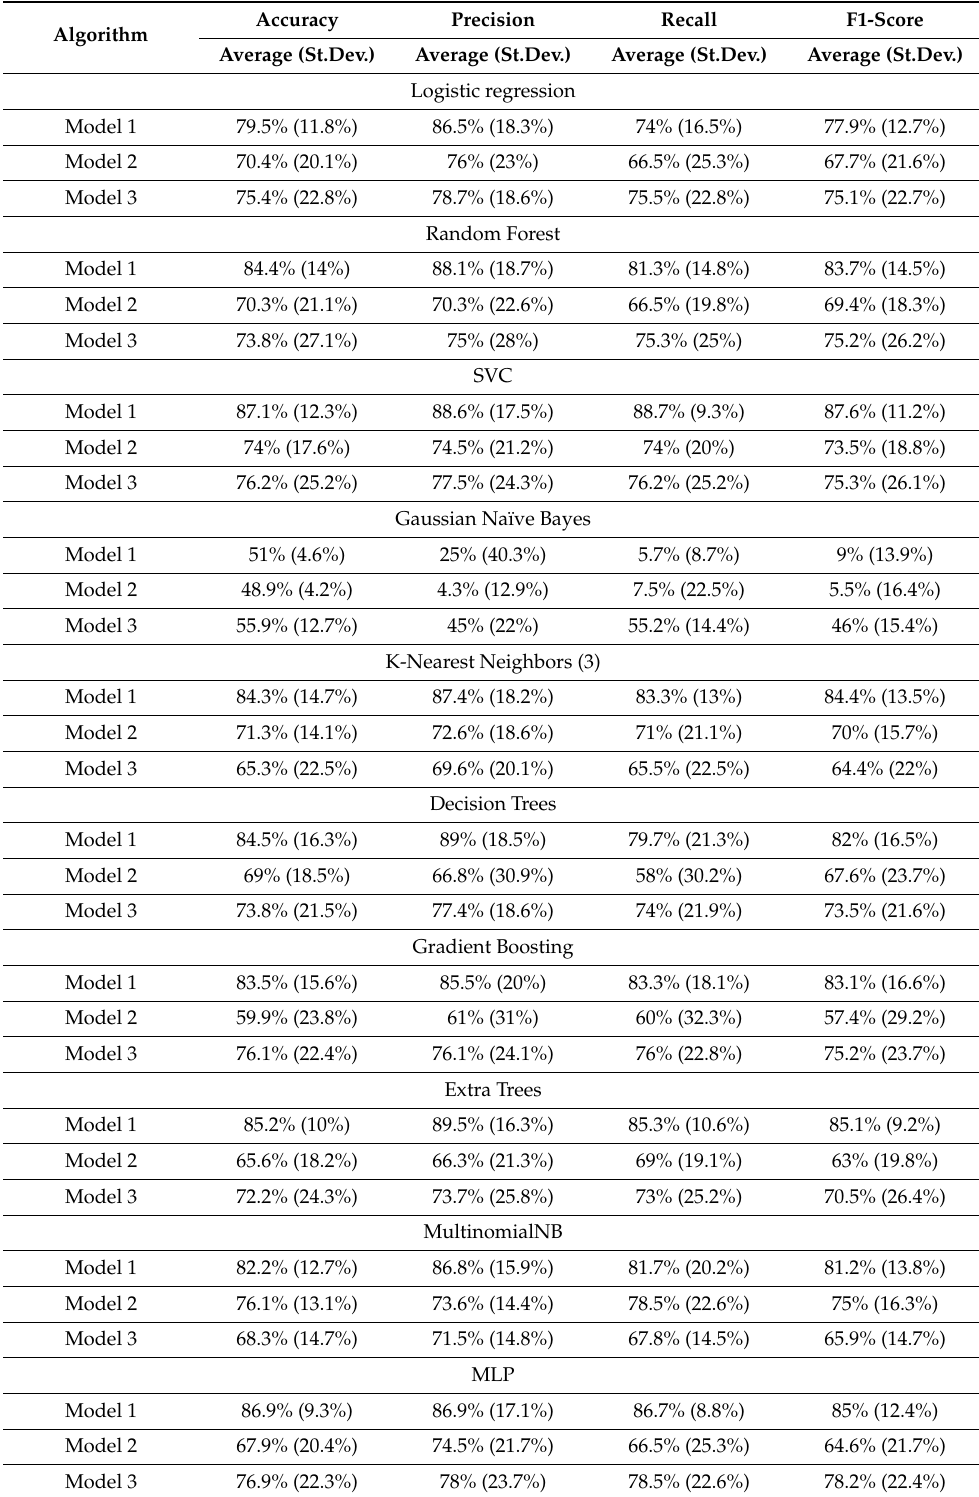
Table 3. Performance of different ML algorithms. Performance of different ML algorithms. For Model 3 precision, recall and f1-score are calculated using